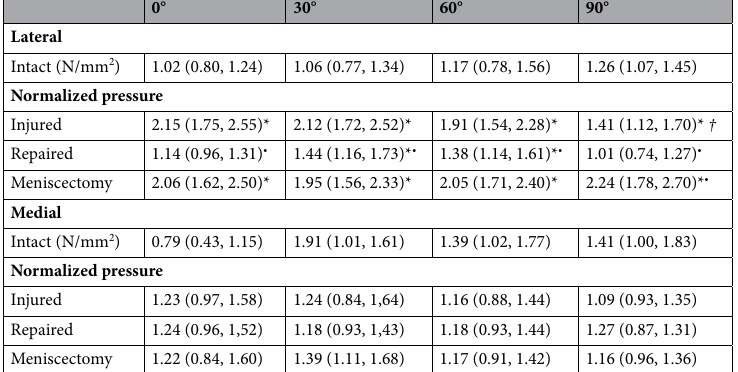
Table 2. Normalized mean pressure relative to the intact condition in the lateral and medial compartments at each flexion angle for the 3 altered meniscal conditions (given as mean value with the 95% CI in parentheses). Values of mean pressure (N/mm 2 ) in the Intact group are provided for reference. *Significant difference with respect to the intact condition. † Significant difference with respect to meniscectomy. • Significant difference with respect to injured.